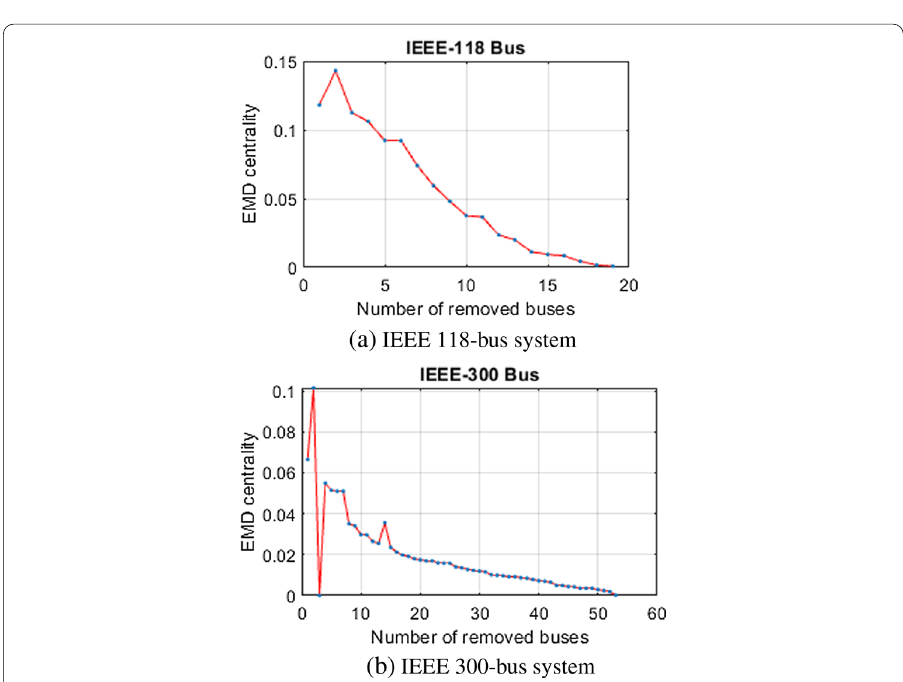
Fig. 4 Proposed iterated EMD